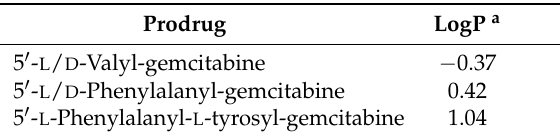
Table 5. Amino acid ester prodrugs of